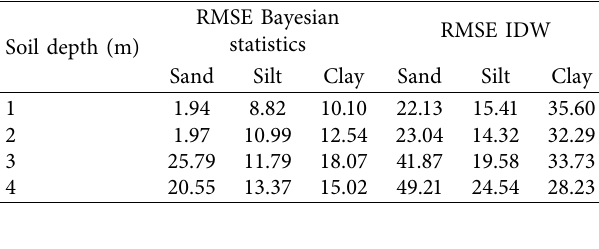
Table 1: The values of RMSE (%) for transfer error interpolation of soil fraction applying Bayesian statistics and